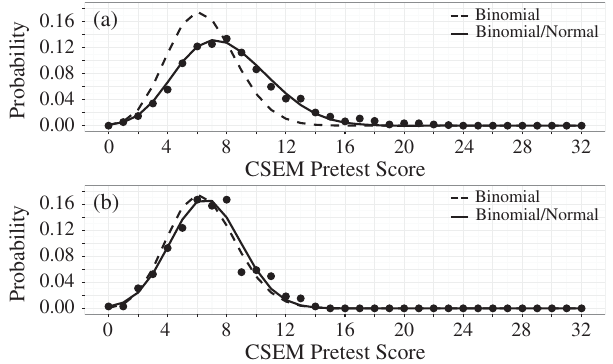
FIG. 8. Model fits for the probability distributions of CSEM pretest scores for (a) male students and (b) female